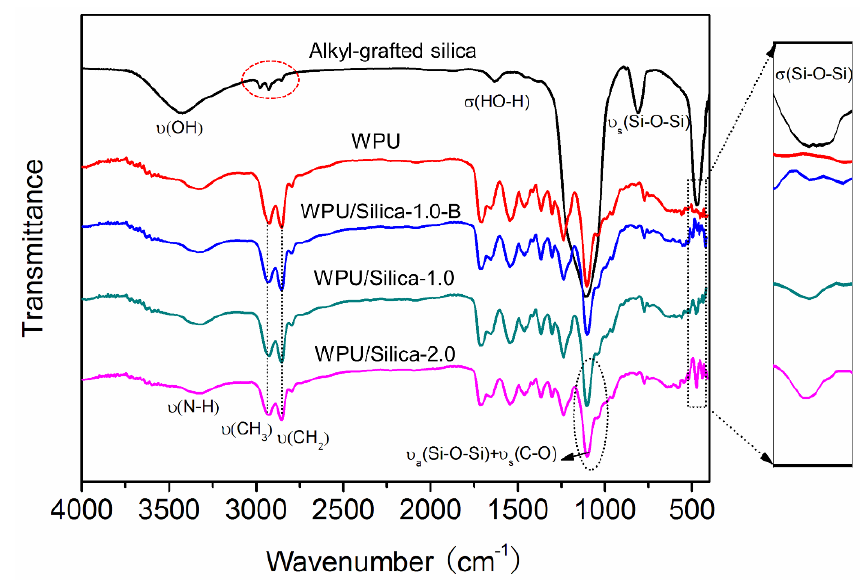
Figure 3. FTIR spectra of alkyl-grafted silica, WPU, and WPU/Silica.